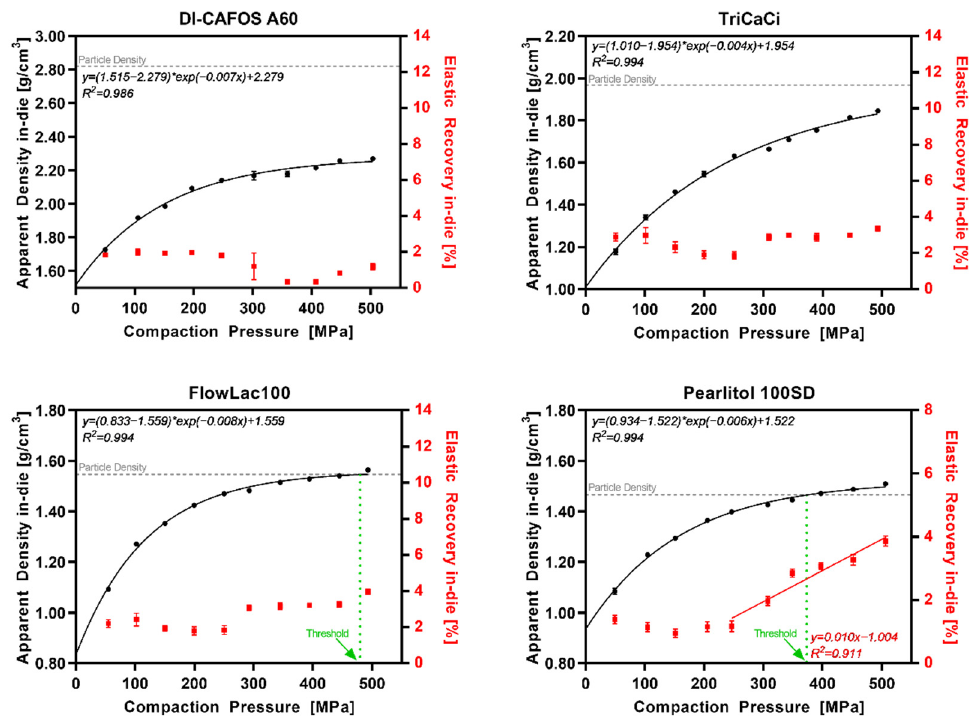
Figure 6. Nonpolymeric excipients: apparent density in-die (black) and elastic recovery in-die (red) at different compaction pressures; particle density (grey dotted line); threshold in CP where ρ app = ρ par (green dotted line).